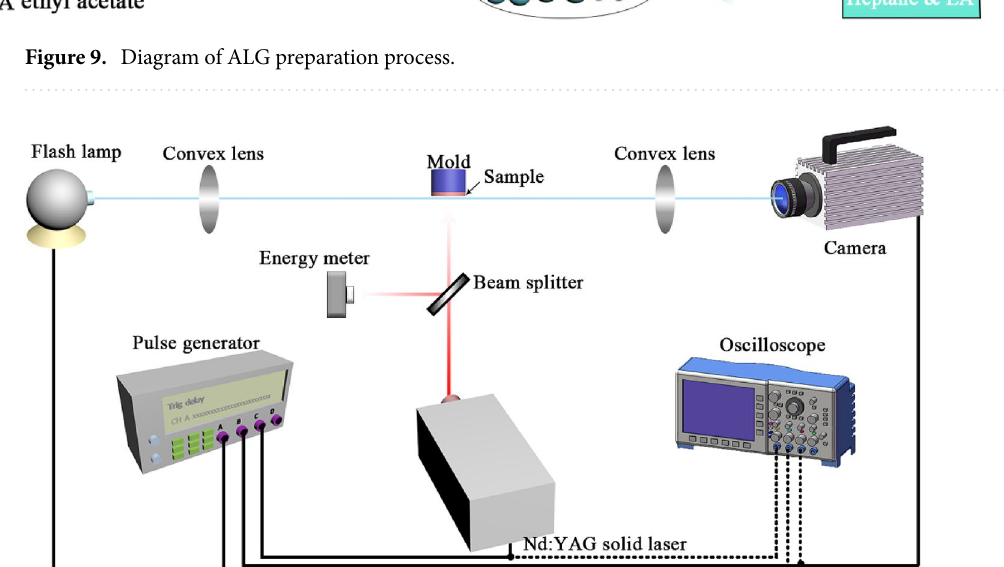
Figure 10. Diagram of experiment setup for the reaction under laser